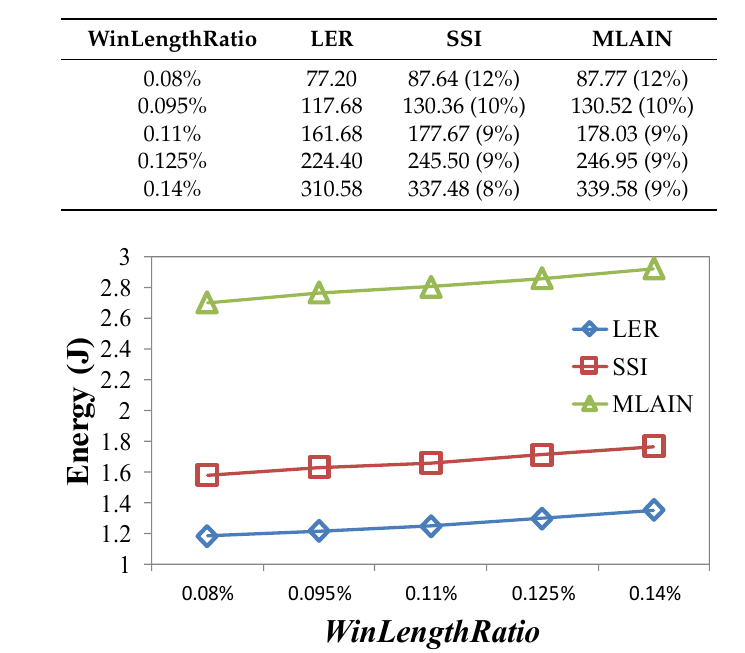
Figure 9. Average access time for changing WinLengthRatio values. Table 3. Average tuning time for changing WinLengthRatio values. Table 3. Average tuning time for changing WinLengthRatio values.